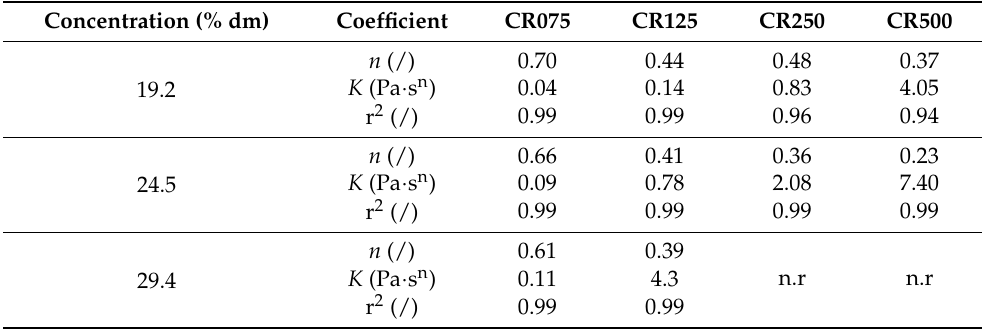
Table 2. Evolution of rheological behavior ( n , K ) of Cassava flour suspension as a function of granulometry and